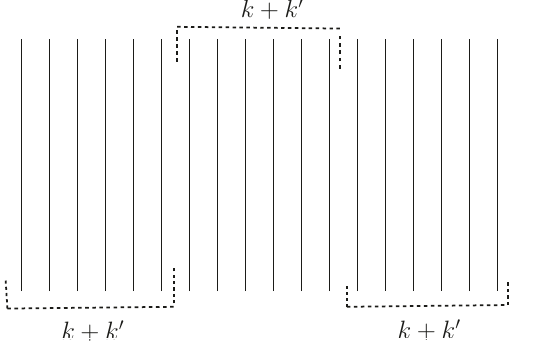
Figure 2 . System of wires decomposed into bundles. The picture shows three bundles constituted of k + k ′ = 6